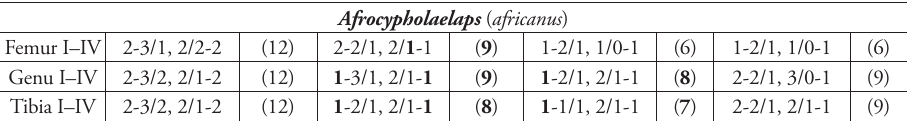
Table 1. Leg chaetotaxy in adults of examined species of Ameroseiidae. Figures in bold face represent infrequent numbers of setae, and non-standard expression of leg